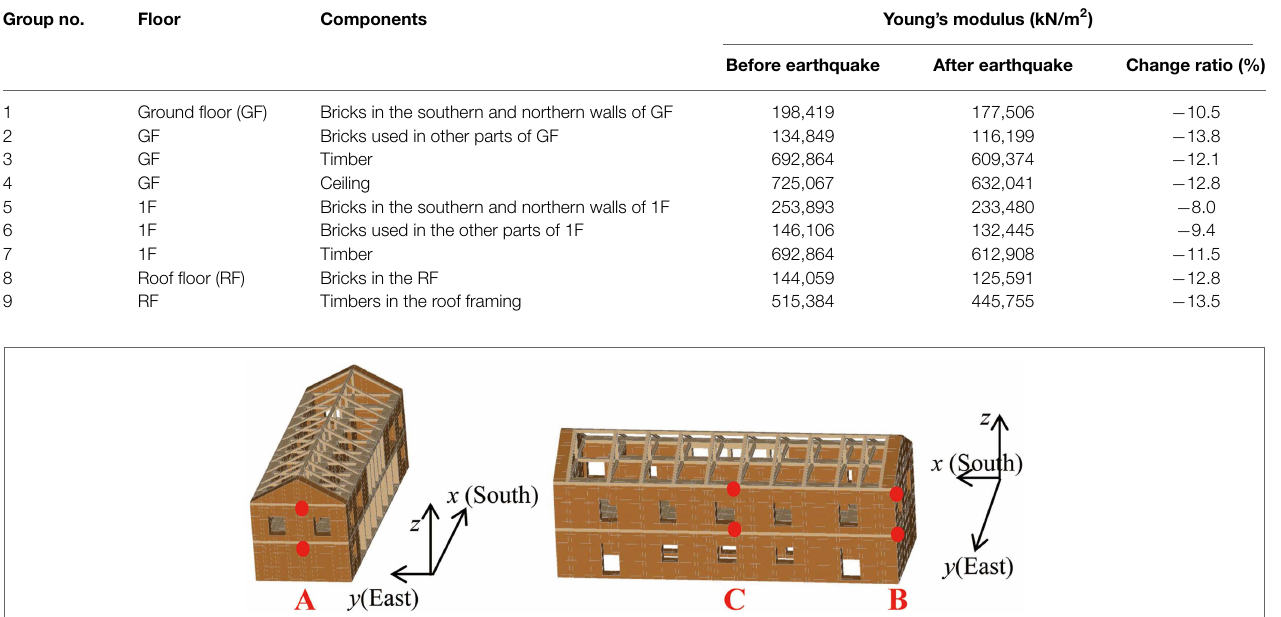
TABLE 8 | Results of stiffness updating for the building after the earthquake: comparison between the values of Young’s modulus in pre-earthquake and post-earthquake finite element models. Group no.